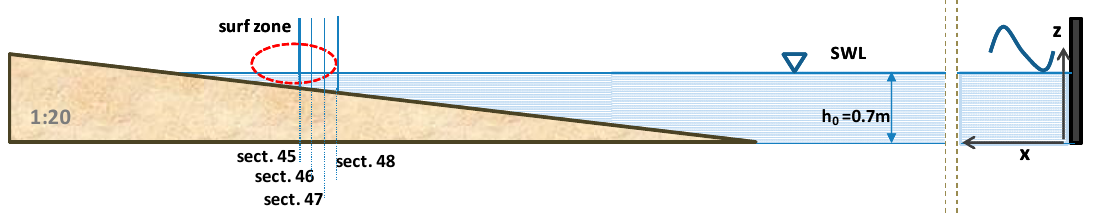
Figure 1. Sketch of the wave flume, with the location of the examined vertical sections.